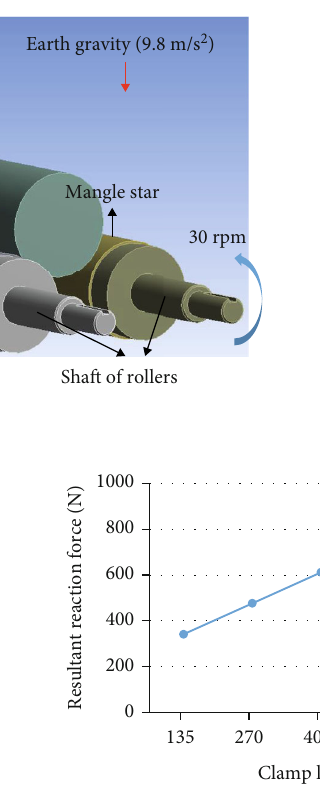
Figure 10: Optimal resultant reaction force (friction